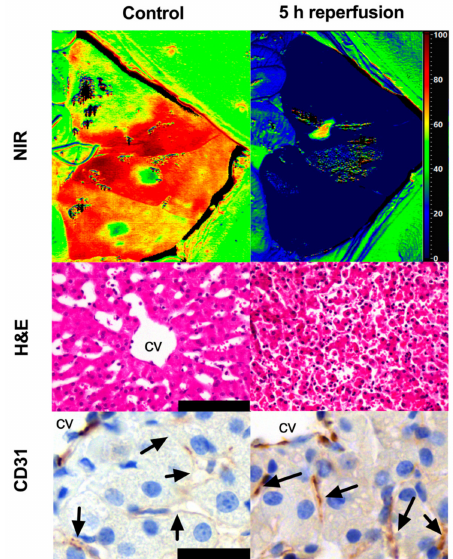
Figure 5. HSI, H&E, and IHC of CD31 expression comparison. The staining for CD31 did not show sinusoidal staining in the control group; this group corresponded to a high level of oxygenation in the HSI image and a normal microarchitecture of the lobe in H&E. After 5 h of reperfusion, a higher expression of CD31 was observed close to the central vein, which corresponded to a low level of oxygenation in the HS image, a deeply congested microvasculature, and an overall parenchymal disruption in H&E. Histology photos were taken with a Leica DM2000 LED microscope, magnification 40 × , scale bar 100 µ m (H&E), 160 × , scale bar 25 µ m